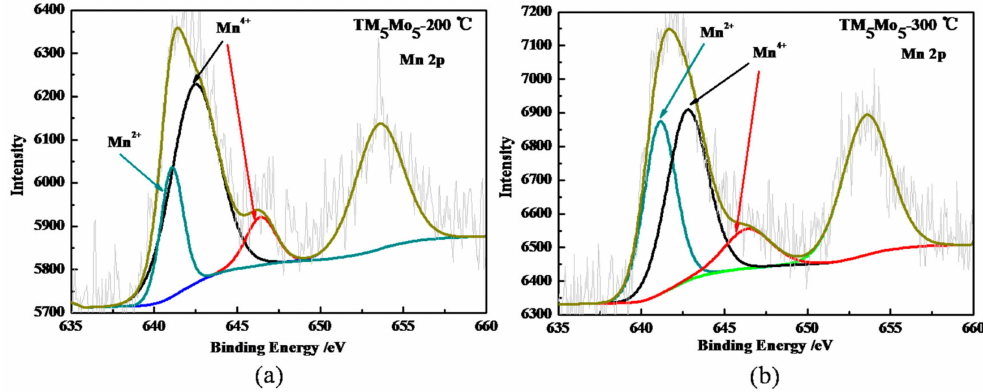
Figure 9. XPS results of long-term test samples: ( a ) 20 h test at 200 ◦ C; ( b ) 20 h test at 300 ◦